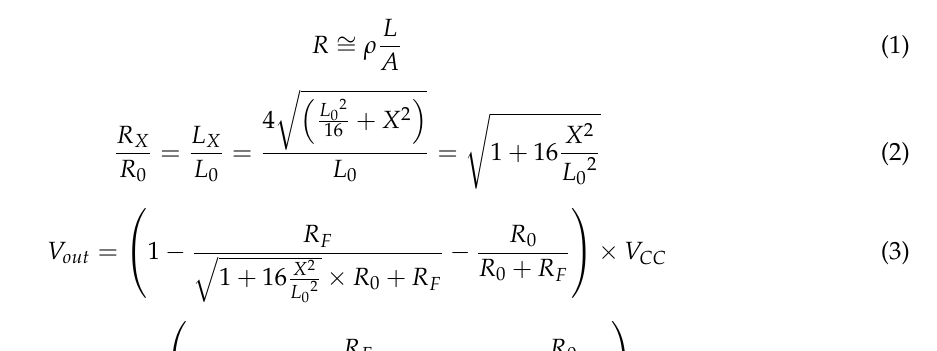
Figure 3. Wheatstone Bridge.